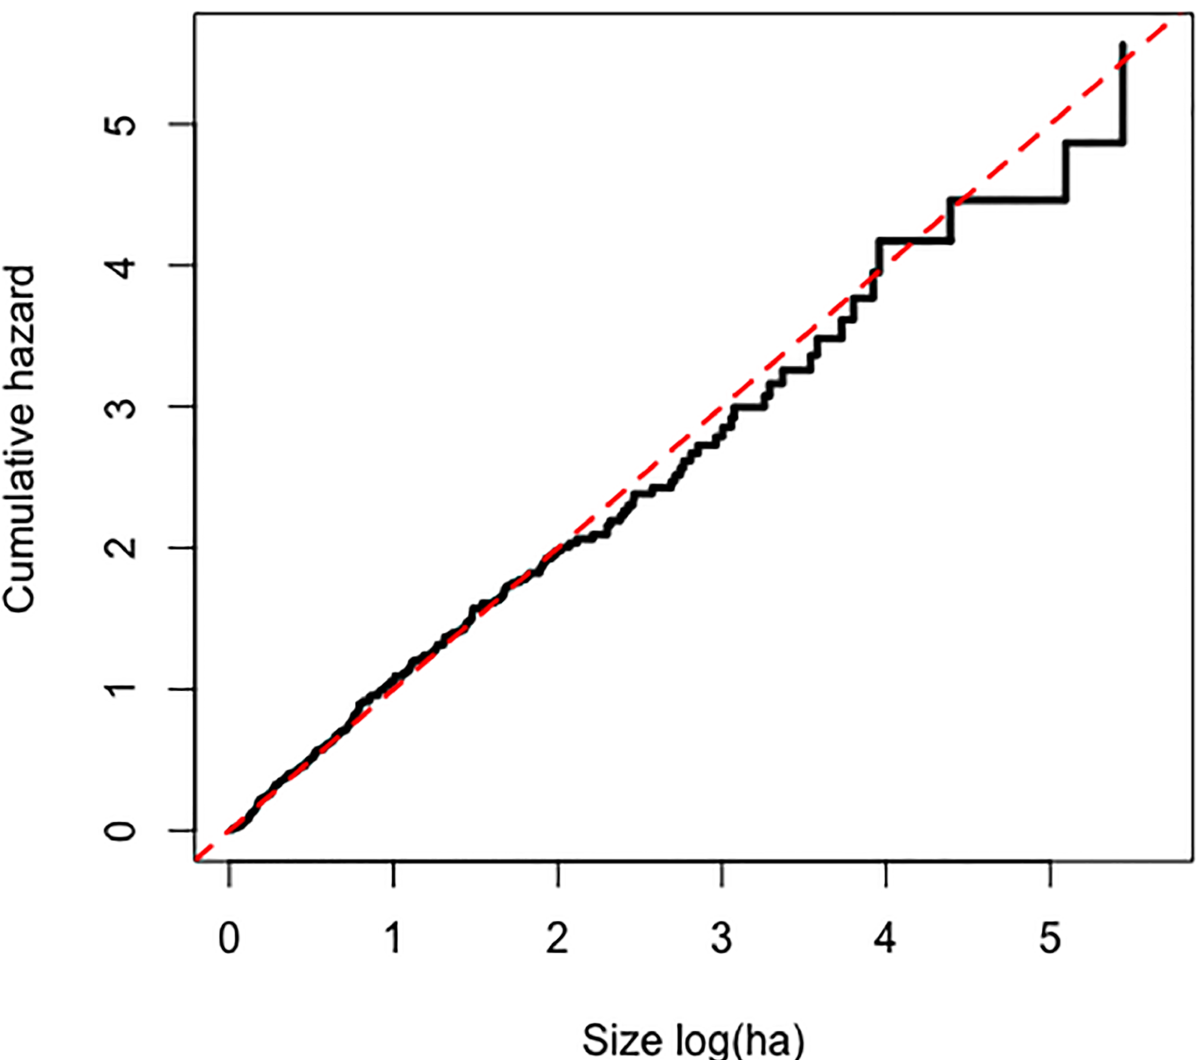
Fig 5. Cox-Snell residuals. The estimated cumulative hazard function of the Cox-Snell residuals (black line) is close to the cumulative hazard of a unit exponential distribution (red dashed line), as expected of a correctly specified model.